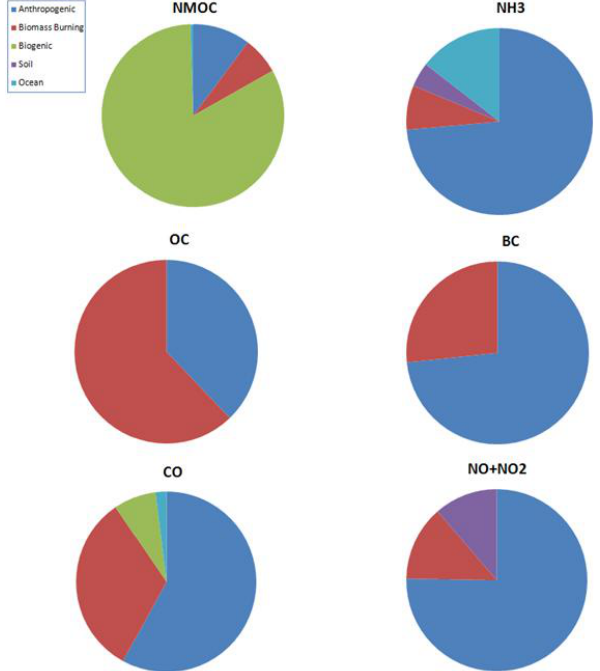
Fig. 4. Distribution of global emissions by source from FINNv1 (for 2008; labeled as Biomass Burning) and the emission inventories applied by MOZART-4 (Emmons et al., 2010a). Anthropogenic emissions include biofuel use.